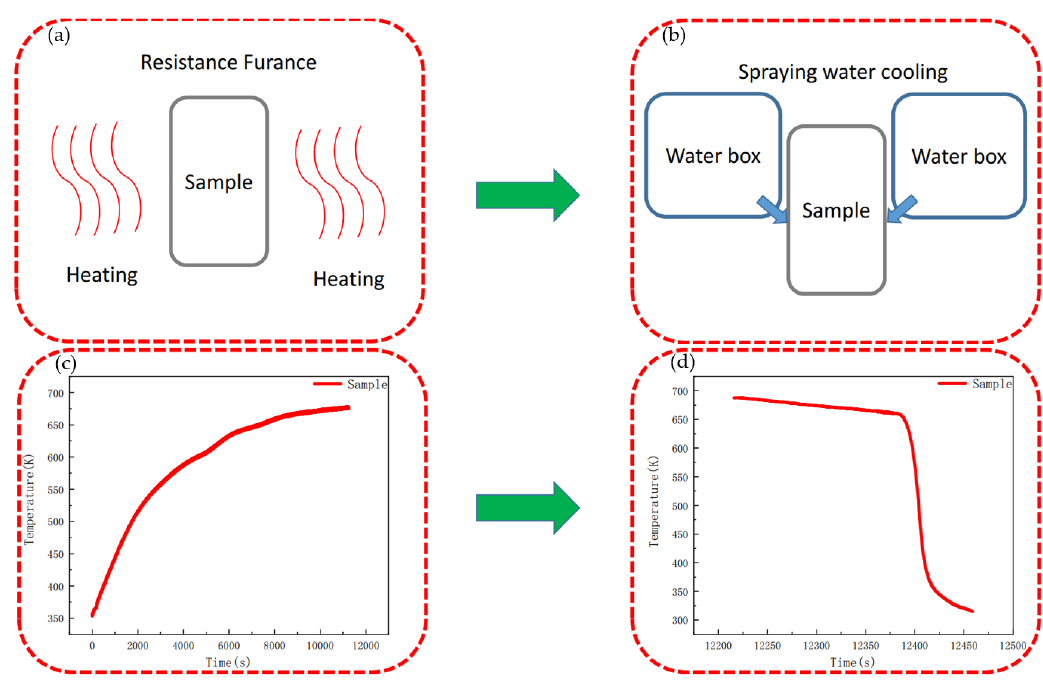
Figure 2. Schematic diagram of DC secondary cooling simulator: ( a ) heat process before water cooling; ( b ) water spray cooling process; ( c ) typical heating curve; ( d ) water cooling curve.